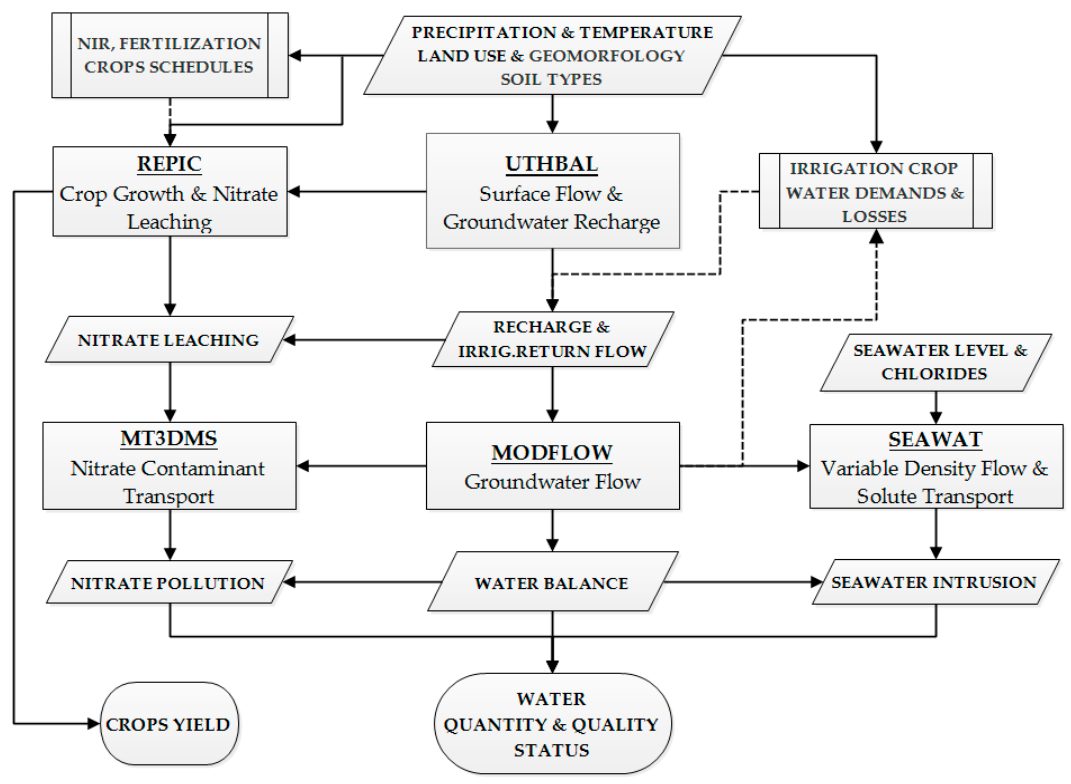
Figure 1. Flow Chart of the Integrated Modeling System.